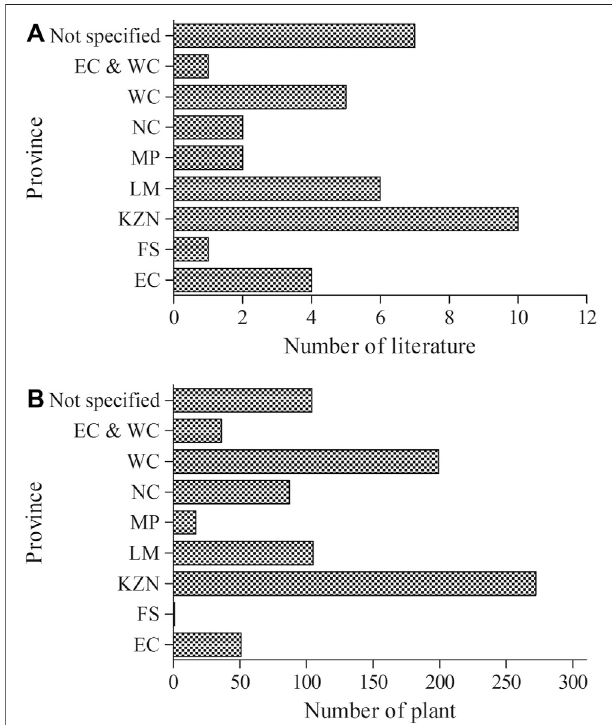
FIGURE2| Distribution ofliterature and plants indicatedasaremedy for painandin fl ammatory-relatedconditionsacrossprovincesinSouthAfrica.EC (cid:1) EasternCape,FS (cid:1) FreeState,KZN (cid:1) KwaZulu-Natal,LM (cid:1) Limpopo,MP (cid:1) Mpumalanga, NC (cid:1) Northern Cape, and WC (cid:1) Western Cape.